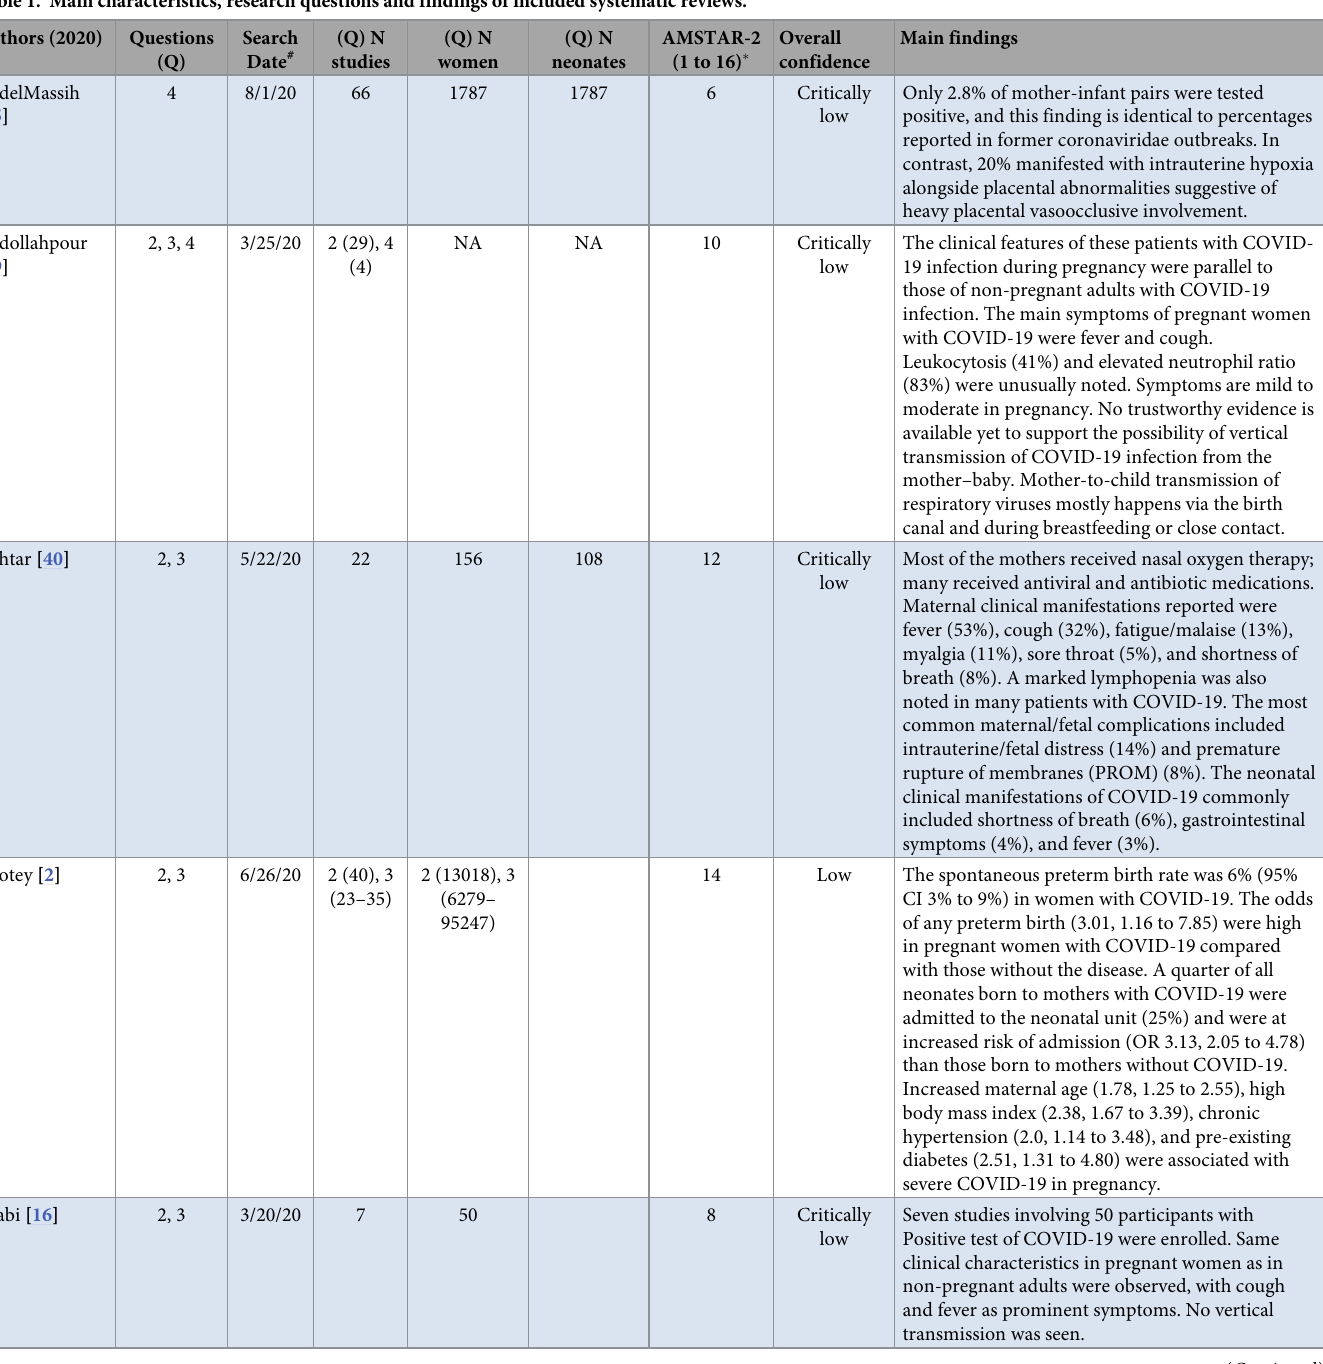
Table 1. Main characteristics, research questions and findings of included systematic